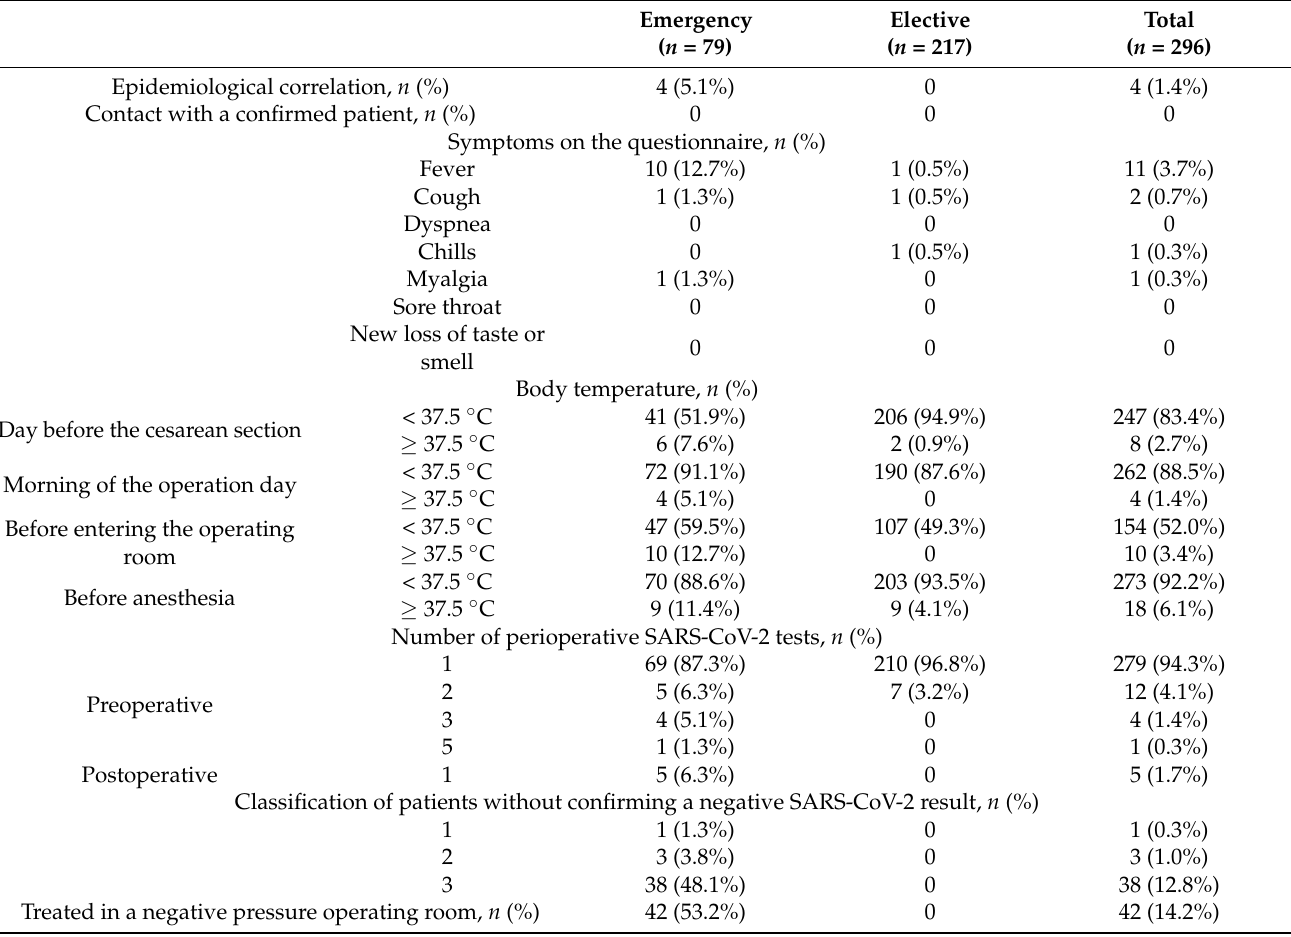
Table 2. COVID-19-related factors of patients undergoing cesarean section.